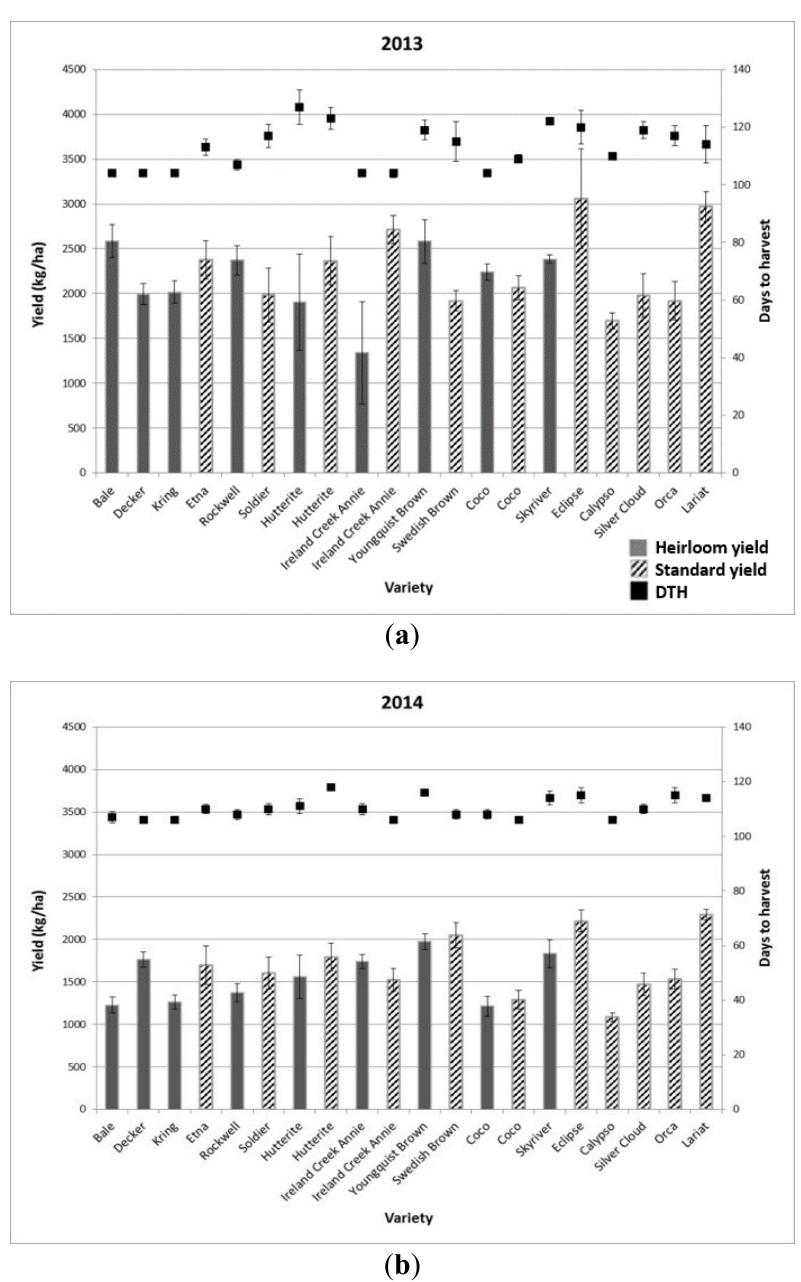
with the longest DTH both years were “Eclipse” (S), “Hutterite” (S) “Skyriver” (H), “Youngquist Brown” (H) and “Orca” (S) (Figure 1).